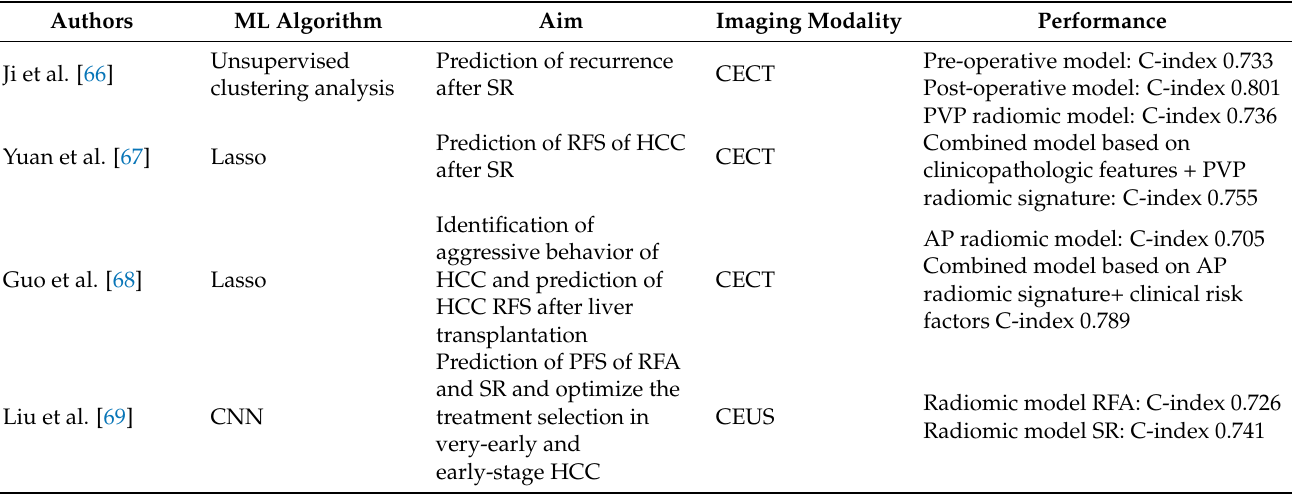
Table 5. Overview of ML algorithms applied to prediction of potentially curative therapies